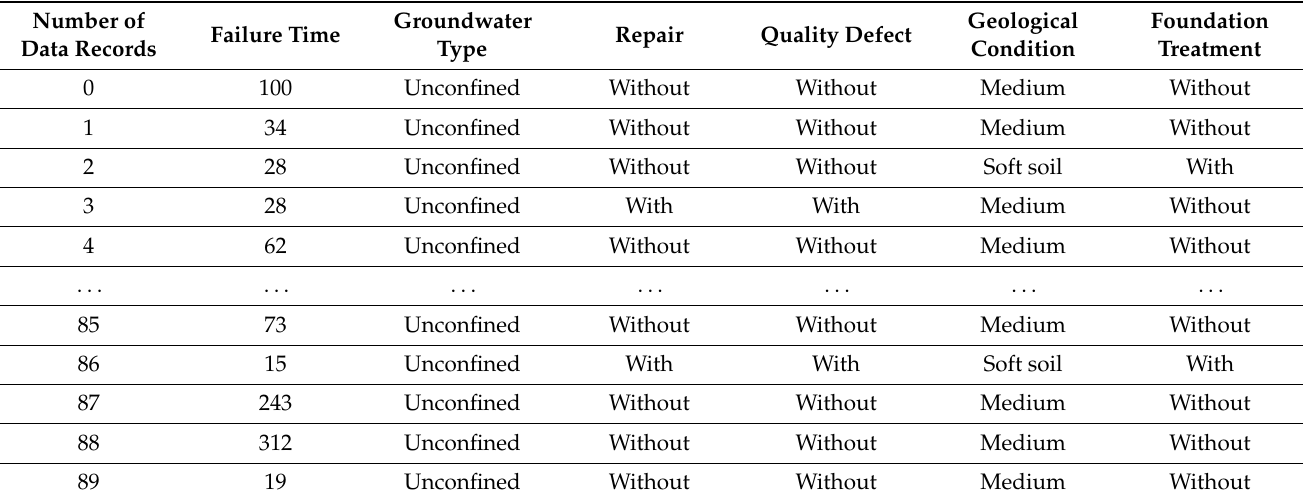
Table 1. A sample of the recorded deformation joint failure data.